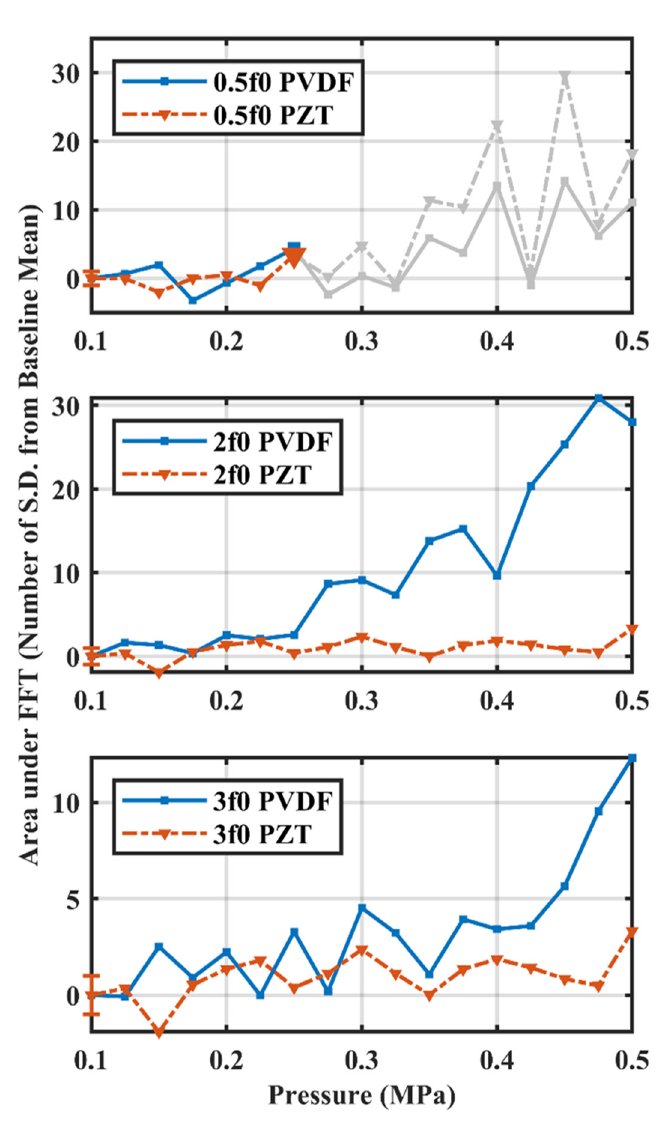
Figure 7. Microbubble emissions at ramping pressure levels captured by PZT and PVDF receivers up to 0.500 MPa. Area under the FFT was calculated as spectrum integration of ±180 Hz at the frequency of interest, normalized by standard deviation from the arithmetic mean of 10 baseline acquisitions. Pressure threshold would be 0.250 MPa for both PZT and PVDF receivers in this measurement. Grey lines indicate the signals acquired at pressures higher than the thresholding pressure. Error bars indicate one standard deviation of baseline acquisitions at 0.100 MPa.